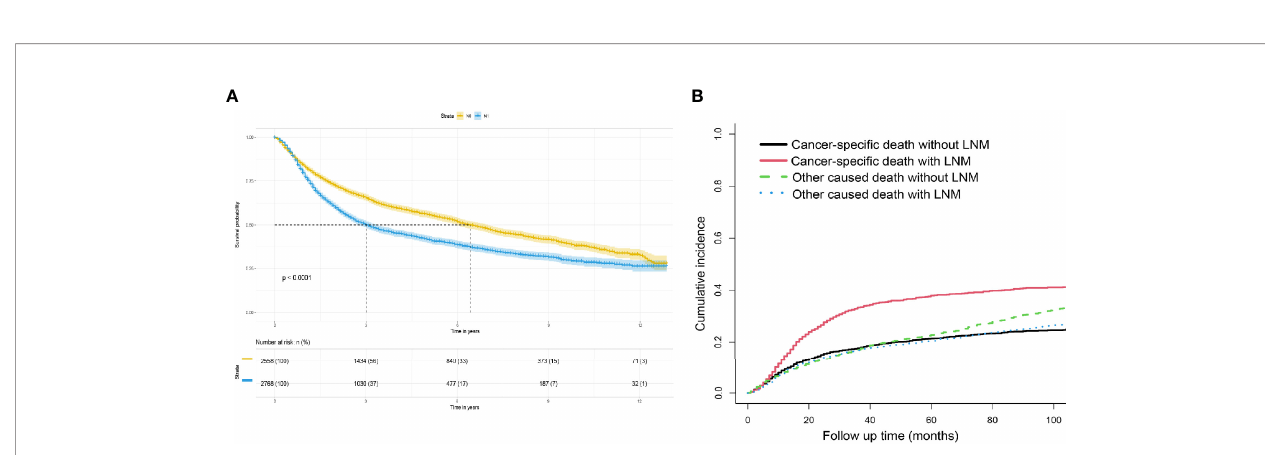
FIGURE 5 | (A) Survival analysis: Kaplan-Meier survival curves grouped according to the lymph node status in the veri fi cation set. (B) Competitive risk curve: death from a non-bladder cancer cause in the veri fi cation set was regarded as a competitive risk